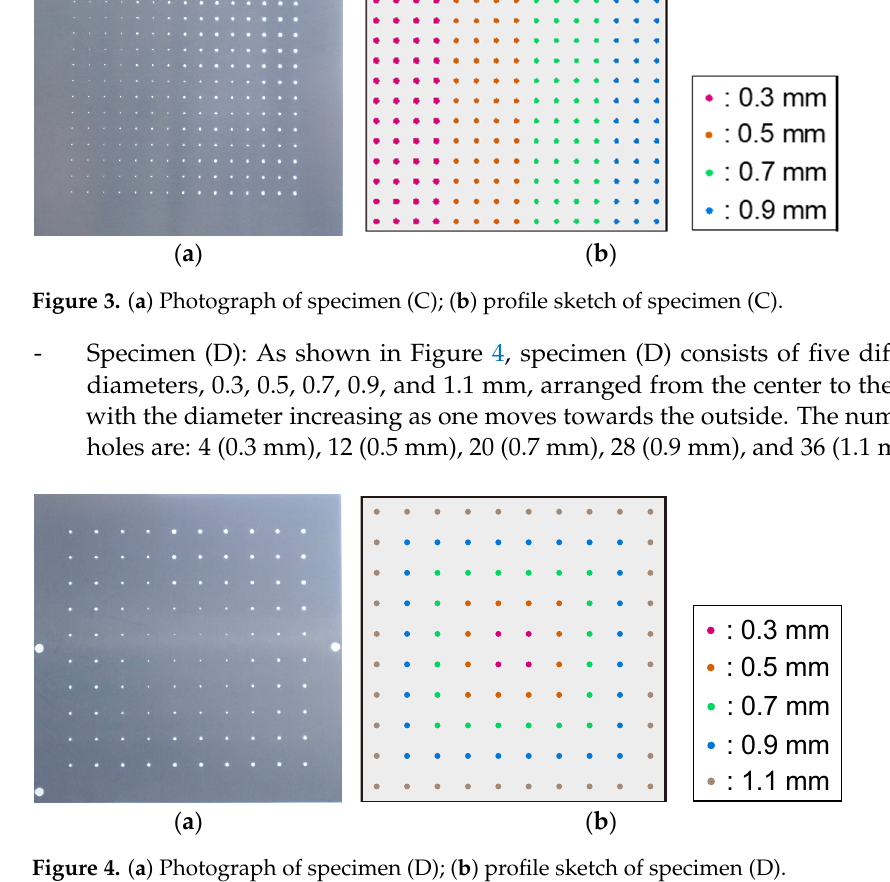
Figure 4. ( a ) Photograph of specimen (D); ( b ) profile sketch of specimen (D). Table 1. Parameters of the specimens. Note that the perforation ratios denote average values.